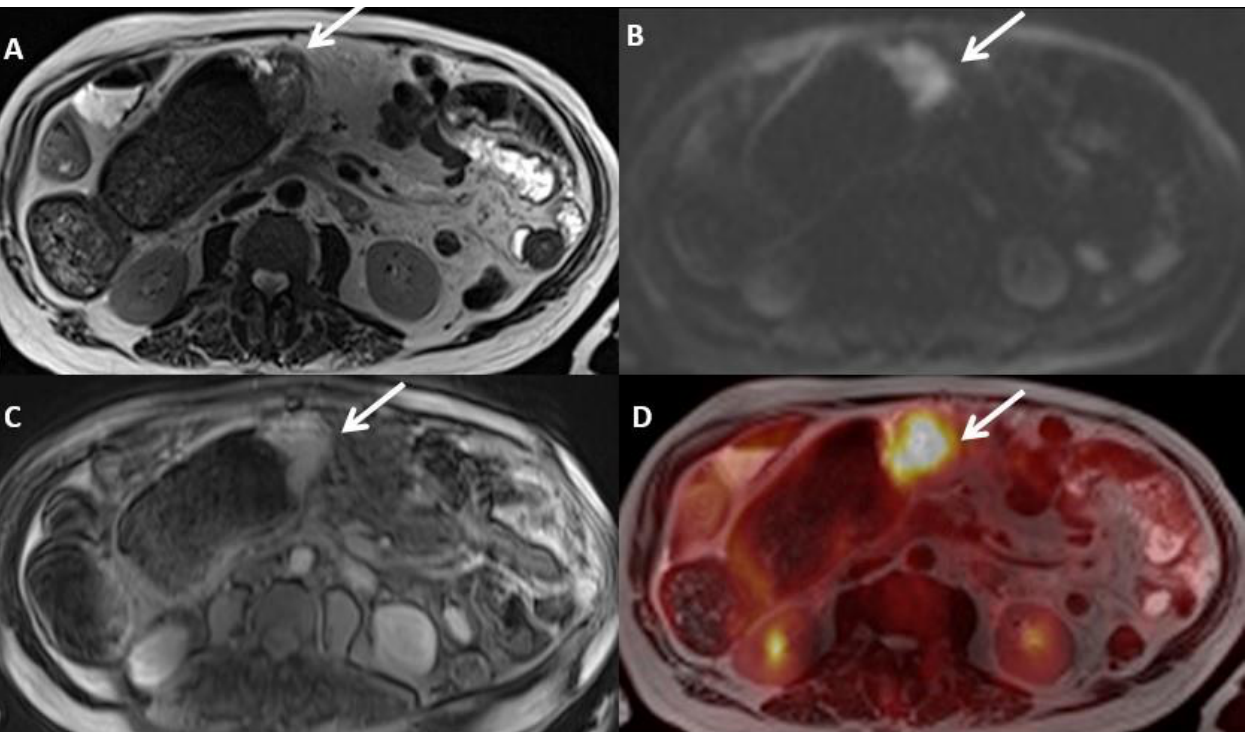
Figure 16. A 73-year-old male patient with peritoneal carcinomatosis secondary to gastric tubular adenocarcinoma, including a 4 cm lesion in the surface of the transverse colon. Lesion is visible in all images (arrows), including T2WI ( A ), DWI ( B ), contrast-enhanced T1WI ( C ), and PET ( D ).